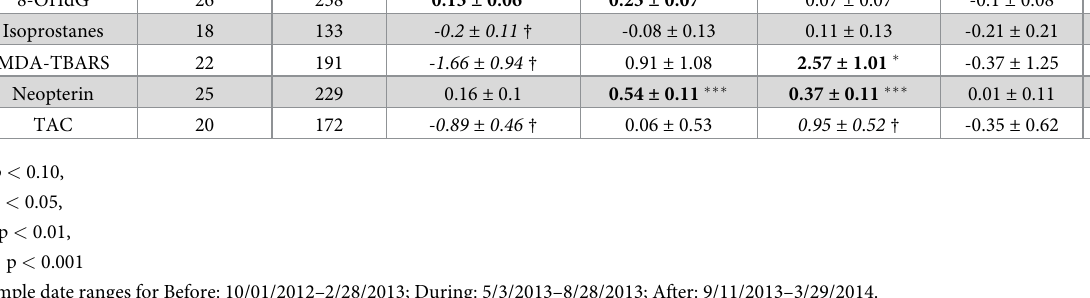
Table 2. Variation in OS biomarkers between periods of before, during, and after a severe respiratory epidemic. Betas and standard deviations of contrasts from gen- eralized linear mixed effects model and percentage of overall variance explained by individual ID as a random effect. Betas of significant contrasts in bold. OS Biomarker n